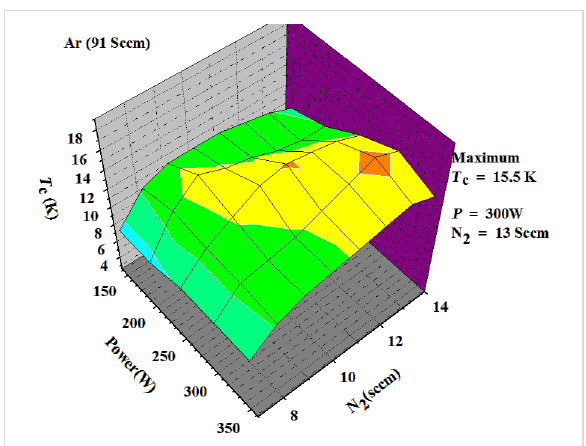
Figure 3: 3D plot constructed to optimize sputter deposition. Each point of the grid corresponds to a sample fabricated with the given set of parameters. We can see that in our apparatus with a basic pressure of 2 × 10 − 5 Pa the highest T c (15.5 K) is obtained with 300 W and a gas mixture of 14% N 2 in Ar.